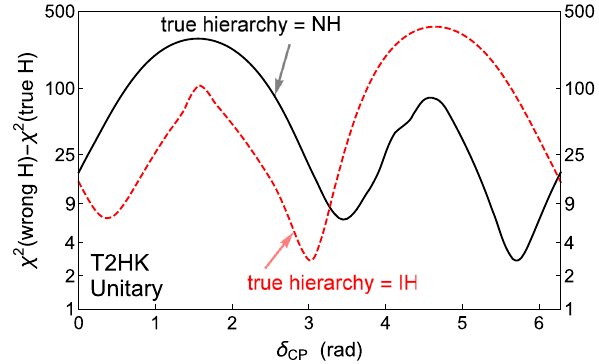
Fig. 7 The difference between the minima (with respect to δ CP only) of χ 2 ((cid:20)) for the wrong and true mass hierarchy, { min χ 2 ( wrong H ) − min χ 2 ( true H ) } ,whentheneutrinomixingisunitary(noheavyneutrino mixing is present), in the T2HK. The results are presented as functions of the true value of δ CP . The black solid line corresponds to the case when the true hierarchy is normal, and the red dashed line to the case when the true hierarchy is